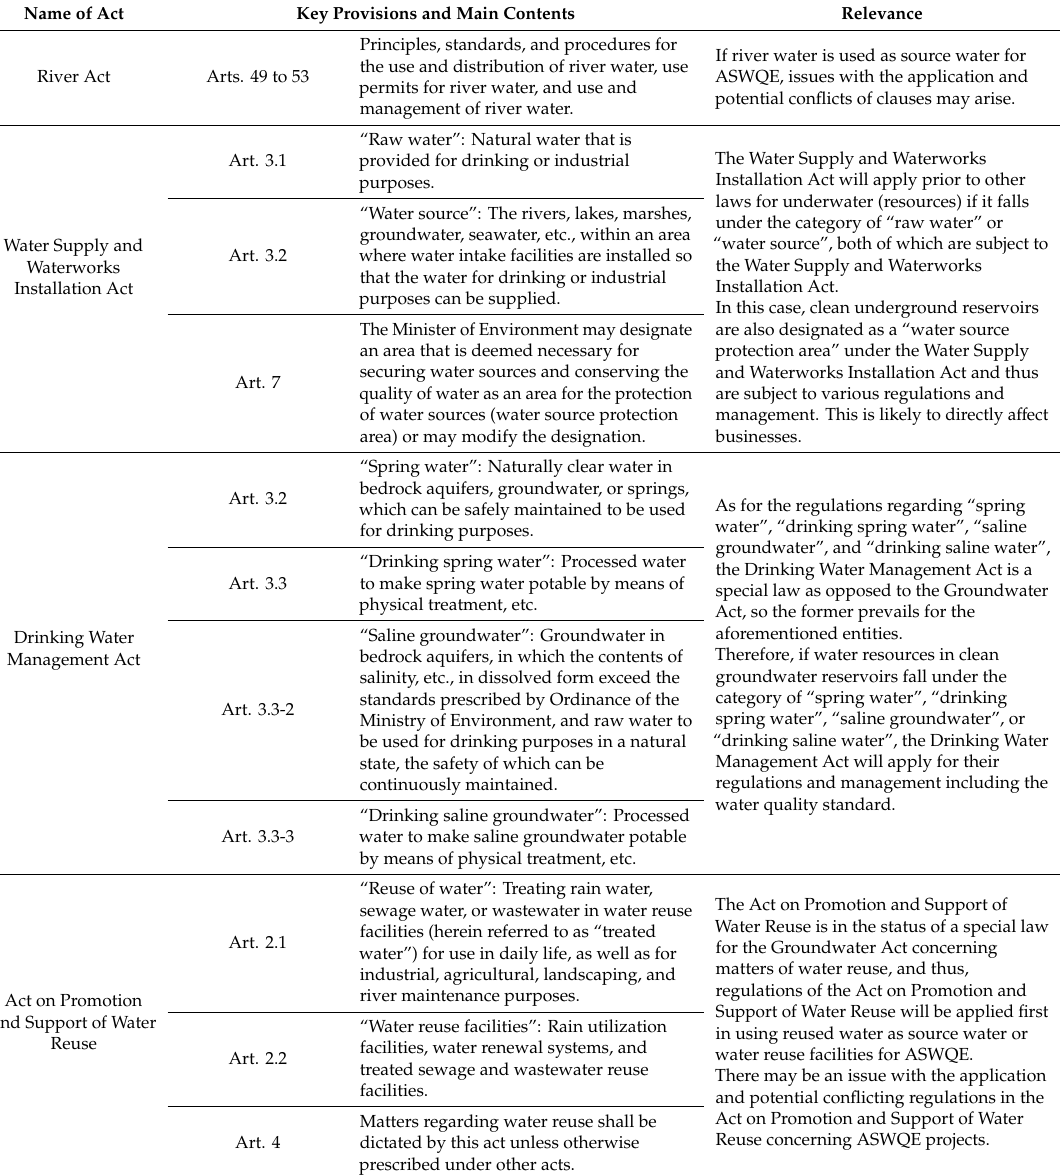
Table 2. Key provisions and contents related to ASWQE projects in other